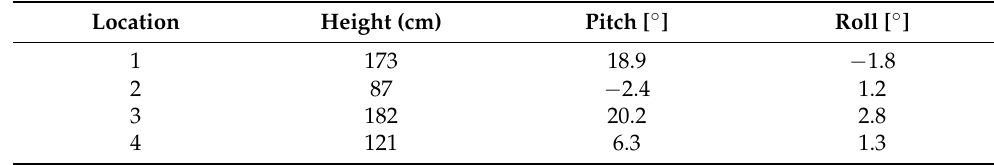
Figure 15. ( a ) Camera/depth sensor position 2 view; ( b ) camera/depth sensor position 3 view. Moreover, different levels of ambient lightning were used for the testing data. For measuring the light, precision light sensor 1127 was used. Three levels of lightning for each different position of the camera/depth sensor were tested: fully illuminated (513 lux), partially illuminated (235 lux) and dark (4 lux). The data recorded for evaluating the model in which 15, 17 and 16 repetitions for sitting, walking, and raising arms respectively were recorded are shown in Table 5. The data were recorded in different camera/depth sensor positions (Figure 14), different light- ing, with partial occlusions and with three different subjects (Table 6) as depicted in Figure 16. Table 5. Total data for testing the RNN. Activity